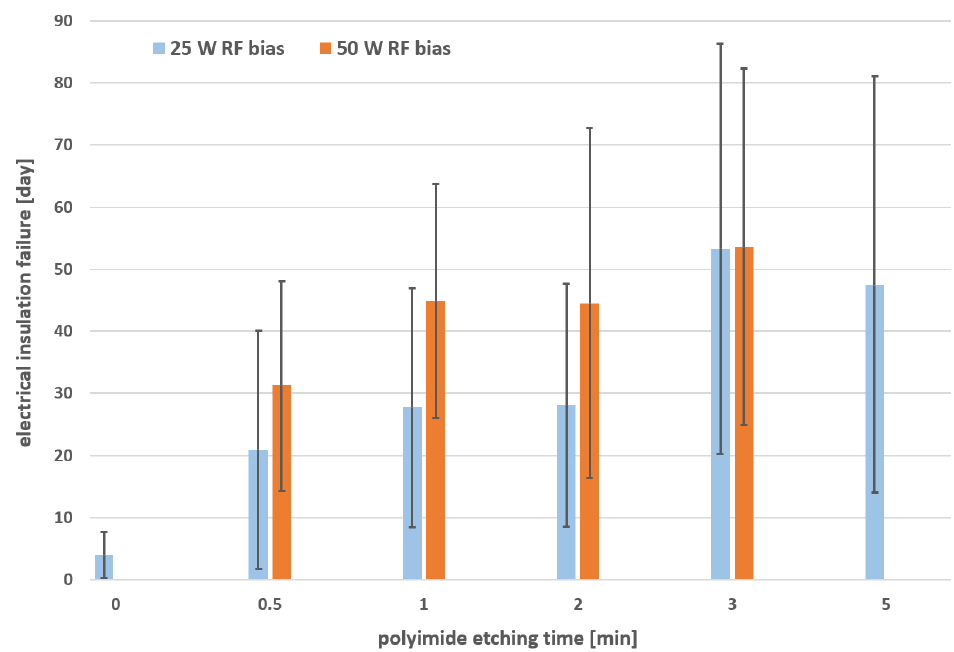
Figure 8. Long-term test results of 10 different polyimide surface treatments. Average values and first standard deviation (error bars) were plotted. The samples etched 0 min were not treated with O 2 plasma for comparison.